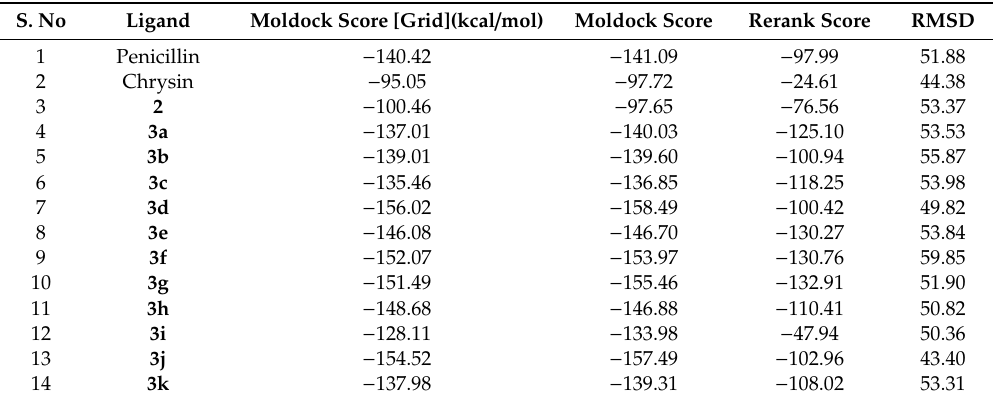
Table 3. 2-Hydroxy-3-chrysino dithiocarbamate derivatives ( 3a – k ) demonstrating highest a ffi nity (Moldock score) against E. coli FabH (pdb id: 1HNJ ) as predicted by molecular docking.